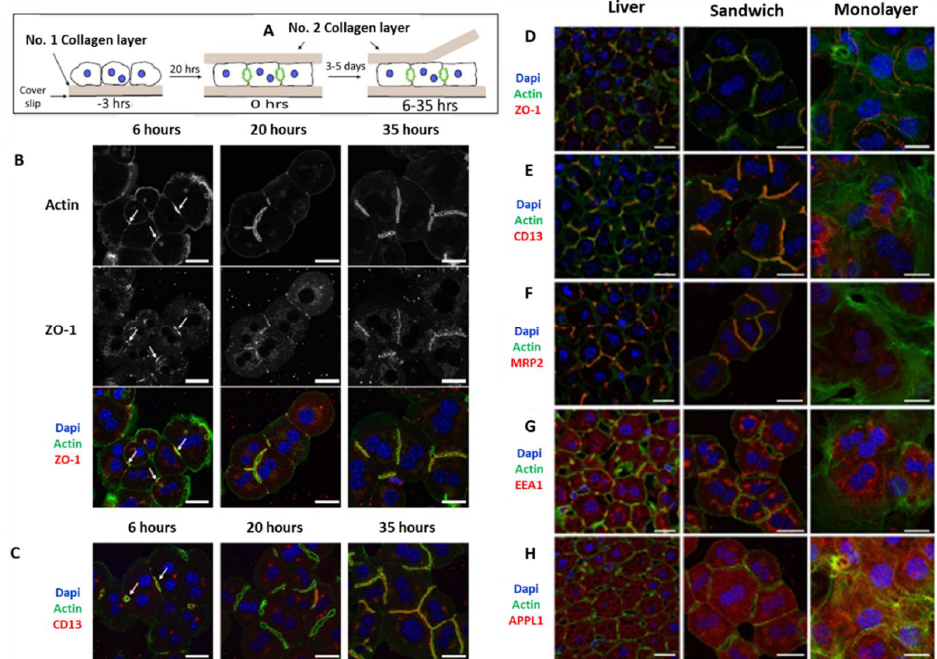
Figure 3. Cell polarity and bile canaliculi network formation in hepatocyte sandwich culture and the comparison of the endocytosis markers with liver slides, representing the in vivo conditions. ( A ) Protocol for fabrication of sandwich culture and removal of the soft collagen top layer for immunofluorescence staining. ( B ) Immunofluorescence images for re-establishment of cell polarity by staining markers for (C) tight junctions (ZO-1, F-Actin) and CD13, a transcytotic marker; A comparison of ( D ) tight junction markers (ZO-1, F-Actin) ( E ) cell polarity marker; ( F ) apical bile acid transporter (MRP2); and endosomal markers i.e., ( G ) EEA, Early endosome antigen 1, and ( H ) APPL1, adaptor protein containing a pleckstrin-homology domain, phosphotyrosine binding domain, and leucine zipper motif 1 between monolayer culture and sandwich culture was visualized and compared with liver slices. Scale bar = 20 µm [41].